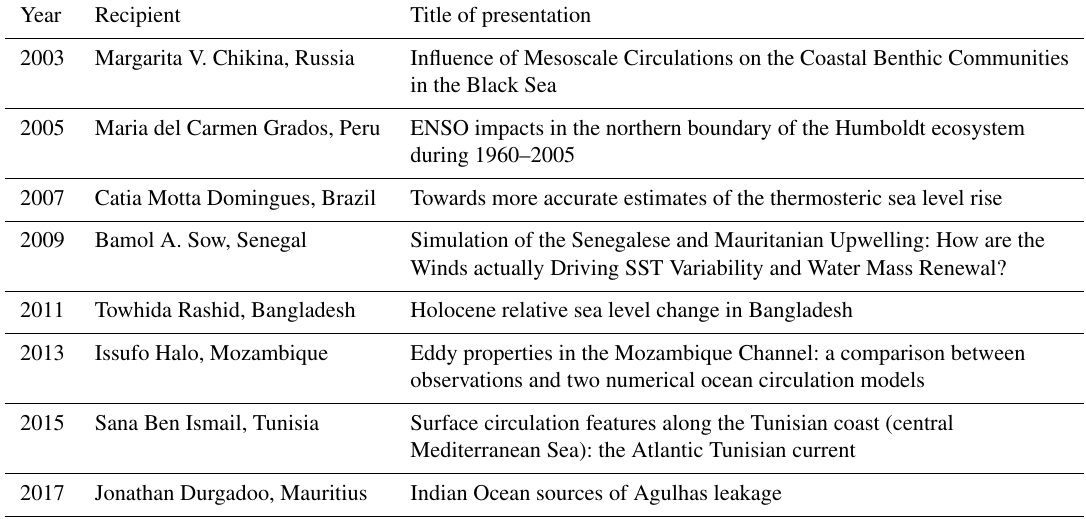
Table 3. Recipients of the Eugene La Fond Medal to